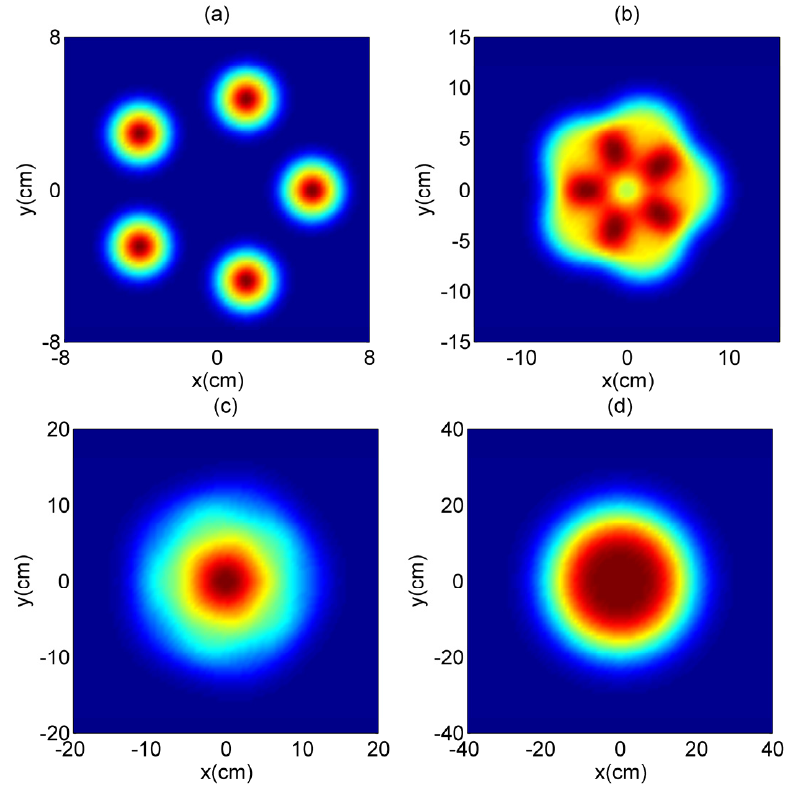
Figure 2. Normalized intensity of a RPLMGSMV beam array with Q = 5 in free space. ( a ) z = 50m, ( b ) z = 200m, ( c ) z = 400m, ( d ) z = 900m. To view the action of Q on intensity distribution, normalized intensity of a RPLMGSMV beam array with Q = 4 in free space are illustrated in Figure 3. As z increases, it is found that the evolution of intensity distributions of a RPLMGSMV beam array with Q = 4 are almost the same with a RPLMGSMV beam array with Q = 5 (Figure 2), the beamlets of beam array will lose the dark hollow profile and become a beam with Gaussian-like beam distribution, the beam array with Q = 4 will translate into the flat-topped profile (Figure 3b). Moreover, the flat-topped profile of a RPLMGSMV beam array is dominated by the MGSM sources at longer distance [33]. By comparing Figures 2 and 3, we can